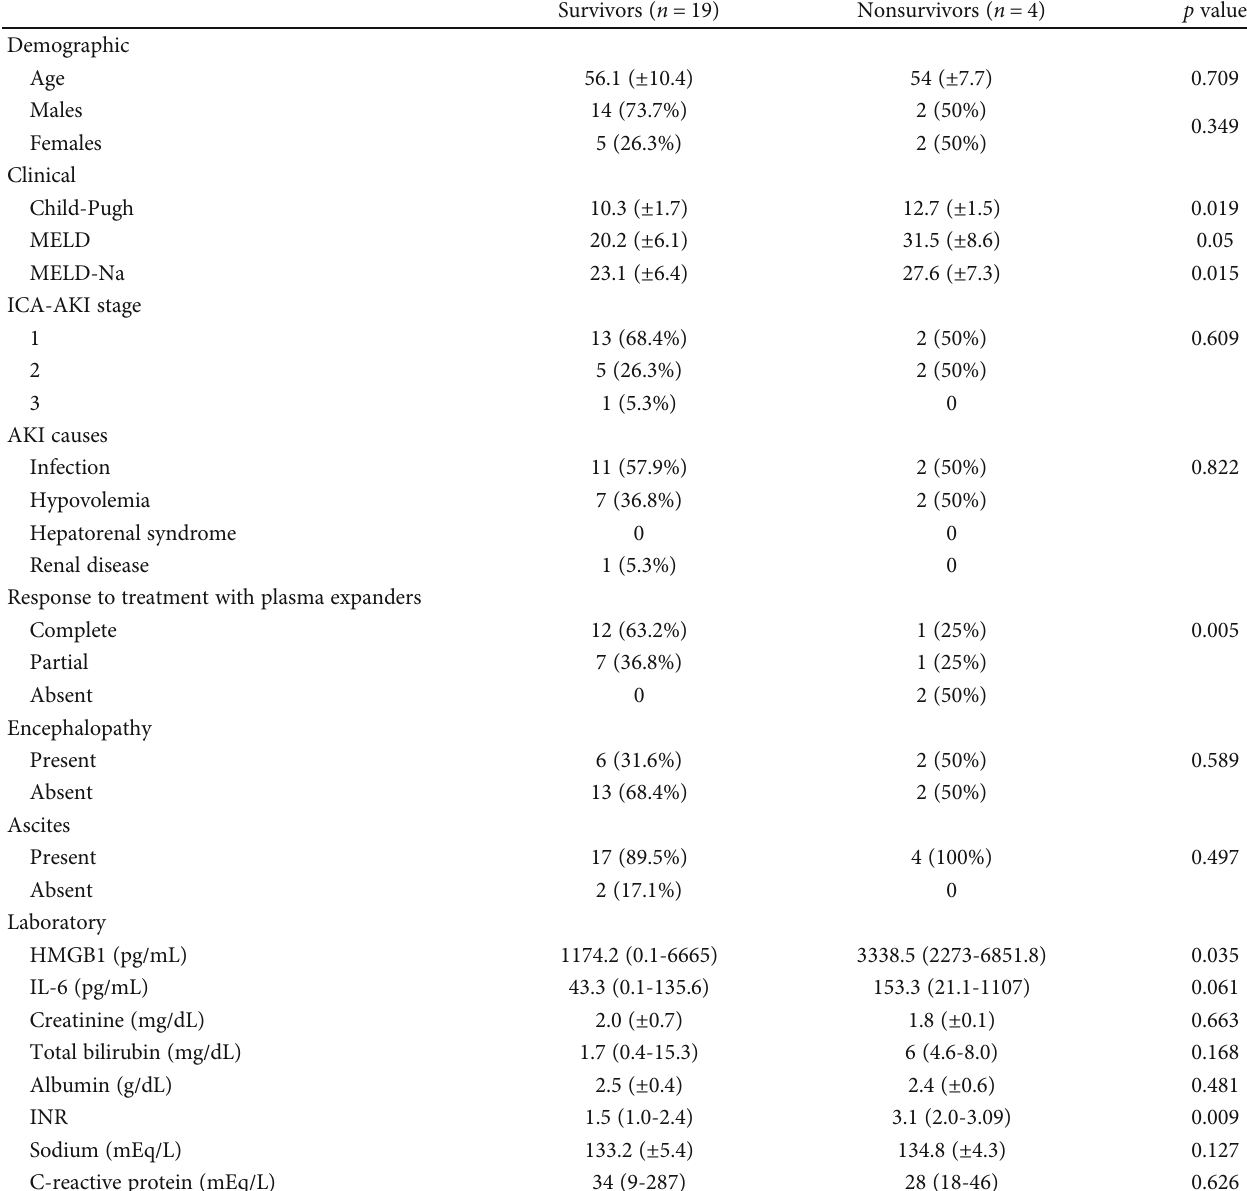
Table 2: Comparison of demographic, clinical, and laboratory variables between survivors and nonsurvivors at 30